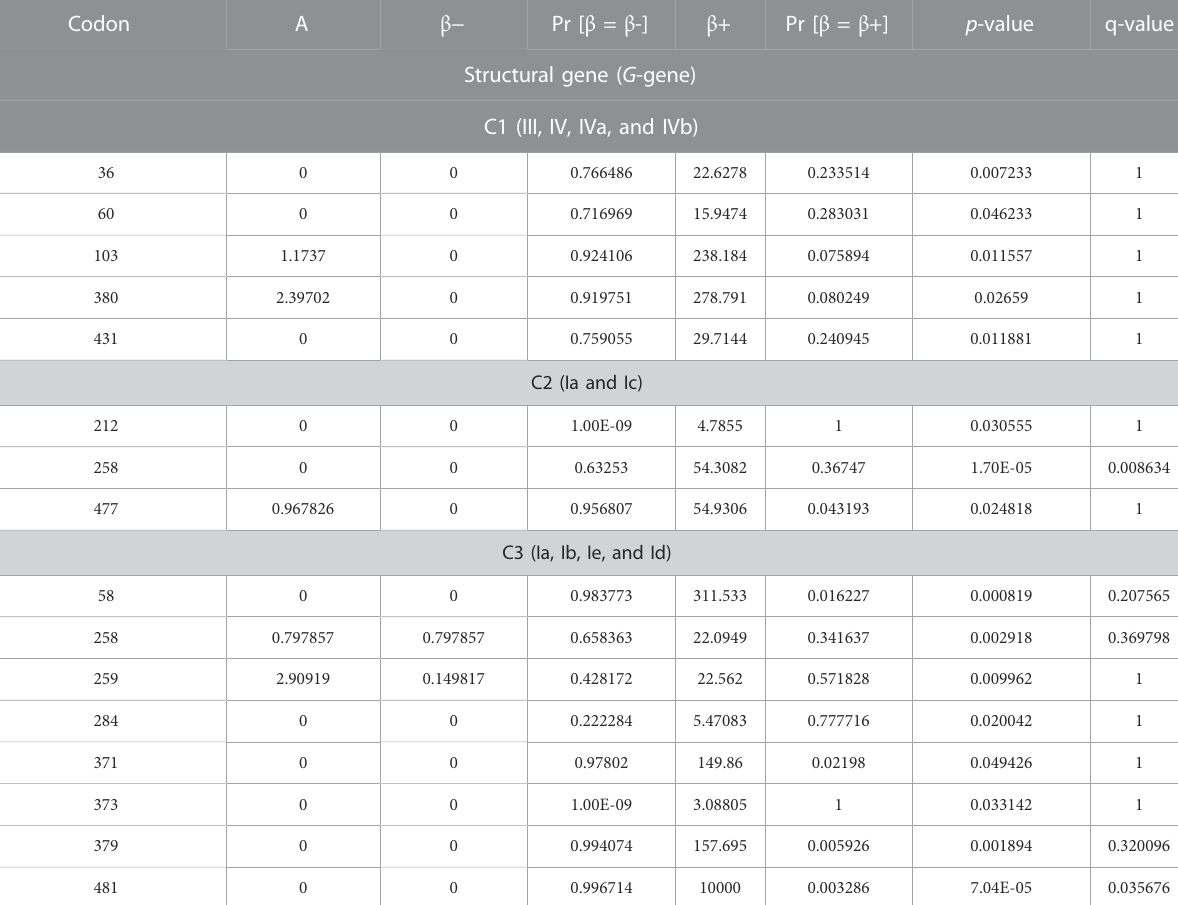
TABLE 2 Positive selection codon sites of VHSV G -gene based on the MEME method ( p < 0.05). The false discovery rate controlled by the “ p -value ” and “ q- value. ”